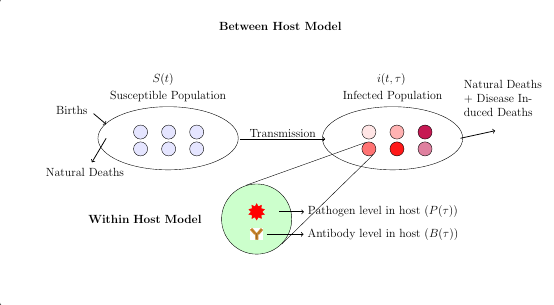
1 Fig. 5. Nested immuno-epidemiological schematic